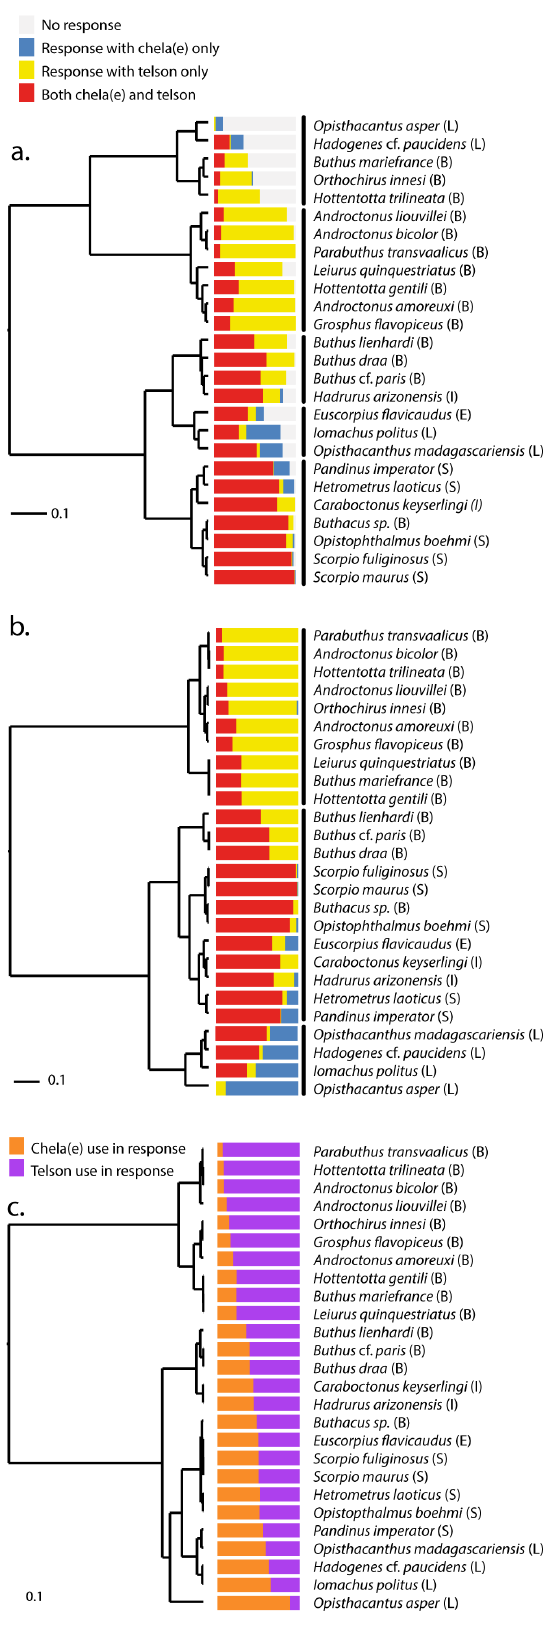
Figure 3. Clustering of species by behavioral response. Clustering based on all response classes (a.), only responses using